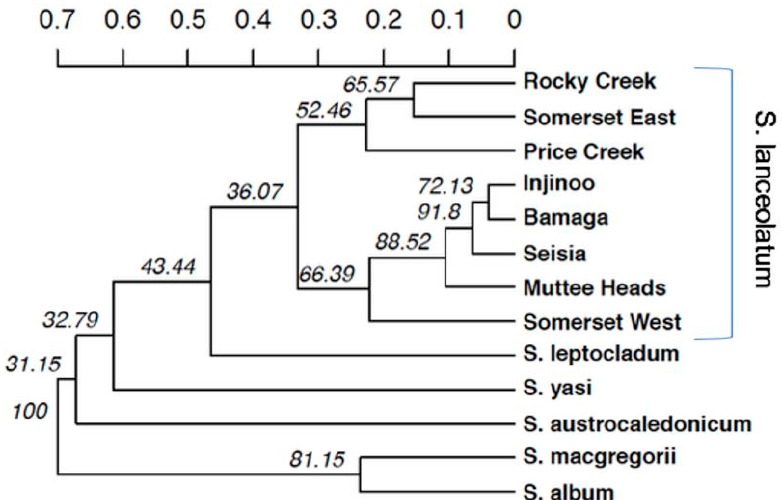
Figure 2. Neighbour Joining tree cluster analysis of the eight Cape York (Queensland, Australia) S. lanceolatum populations (indicated on right of tree) and five Santalum congeners. Numbers above branches represent bootstrap support with 999 permutations calculated using Nei’s genetic dis- tance.